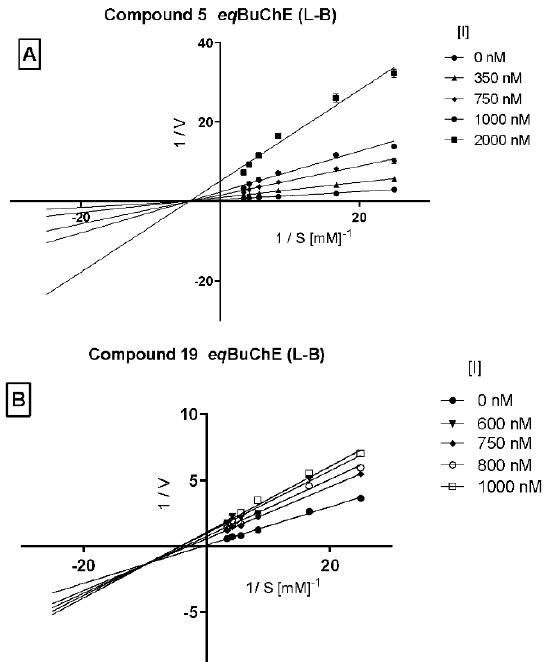
Figure 4. Lineweaver–Burk plot illustrating non-competitive type of eq BuChE inhibition by com- pound 5 panel ( A ) and mixed type of enzyme inhibition by compound 19 panel ( B ). S = substrate (BTC; butrylthiocholine); V = initial velocity rate; I = inhibitor concentration. Cornish–Bowden (Figure 5A,B) plots confirmed non-competitive eq BuChE